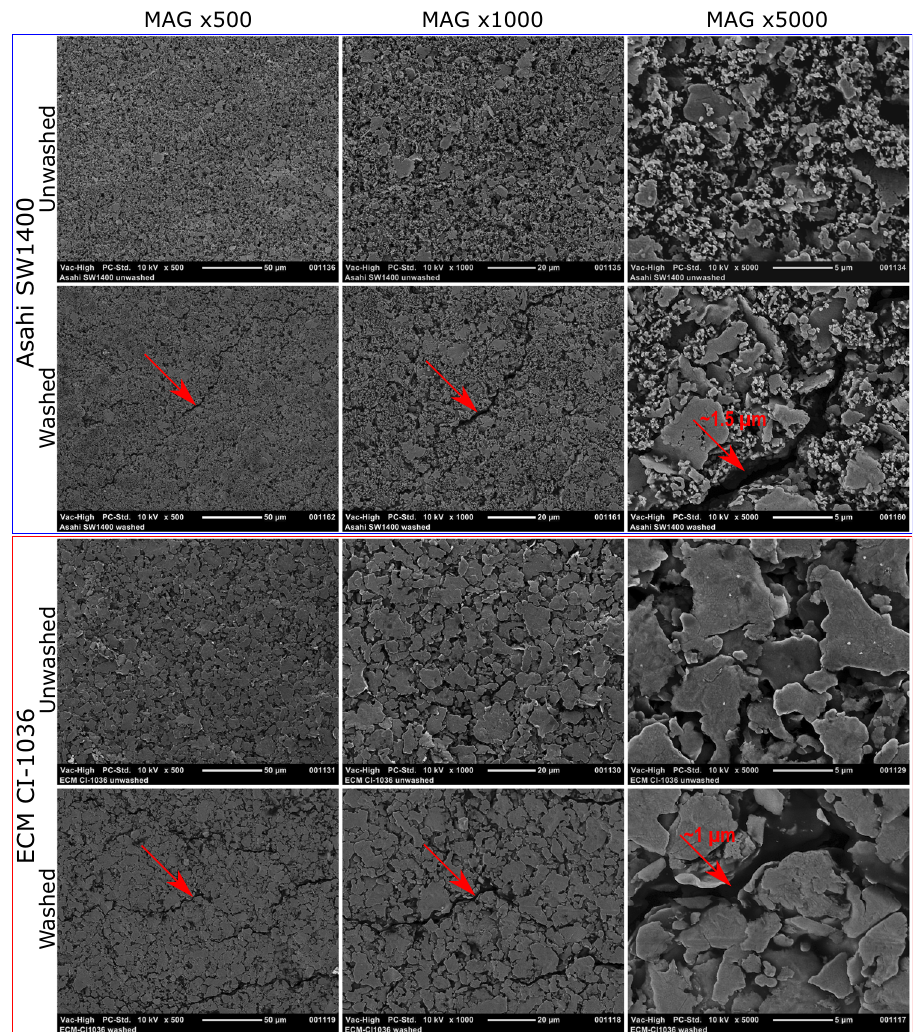
Fig. 6 Macroscopic comparison of washed and unwashed electrodes (Asahi SW1400 and ECM CI-1036) at various magni fi cations. SEM images at ×500 magni fi cation show the existence of cracks on the surface of the washed samples while the unwashed samples remain intact. SEM image at ×1000 magni fi cation points out the presence of cracks over the surface of the washed samples. The SEM images at magni fi cation ×5000 show the details of the cracks that are approximately 1 – 2 µm wide. Red arrows emphasize the location of the cracks at various SEM magni fi